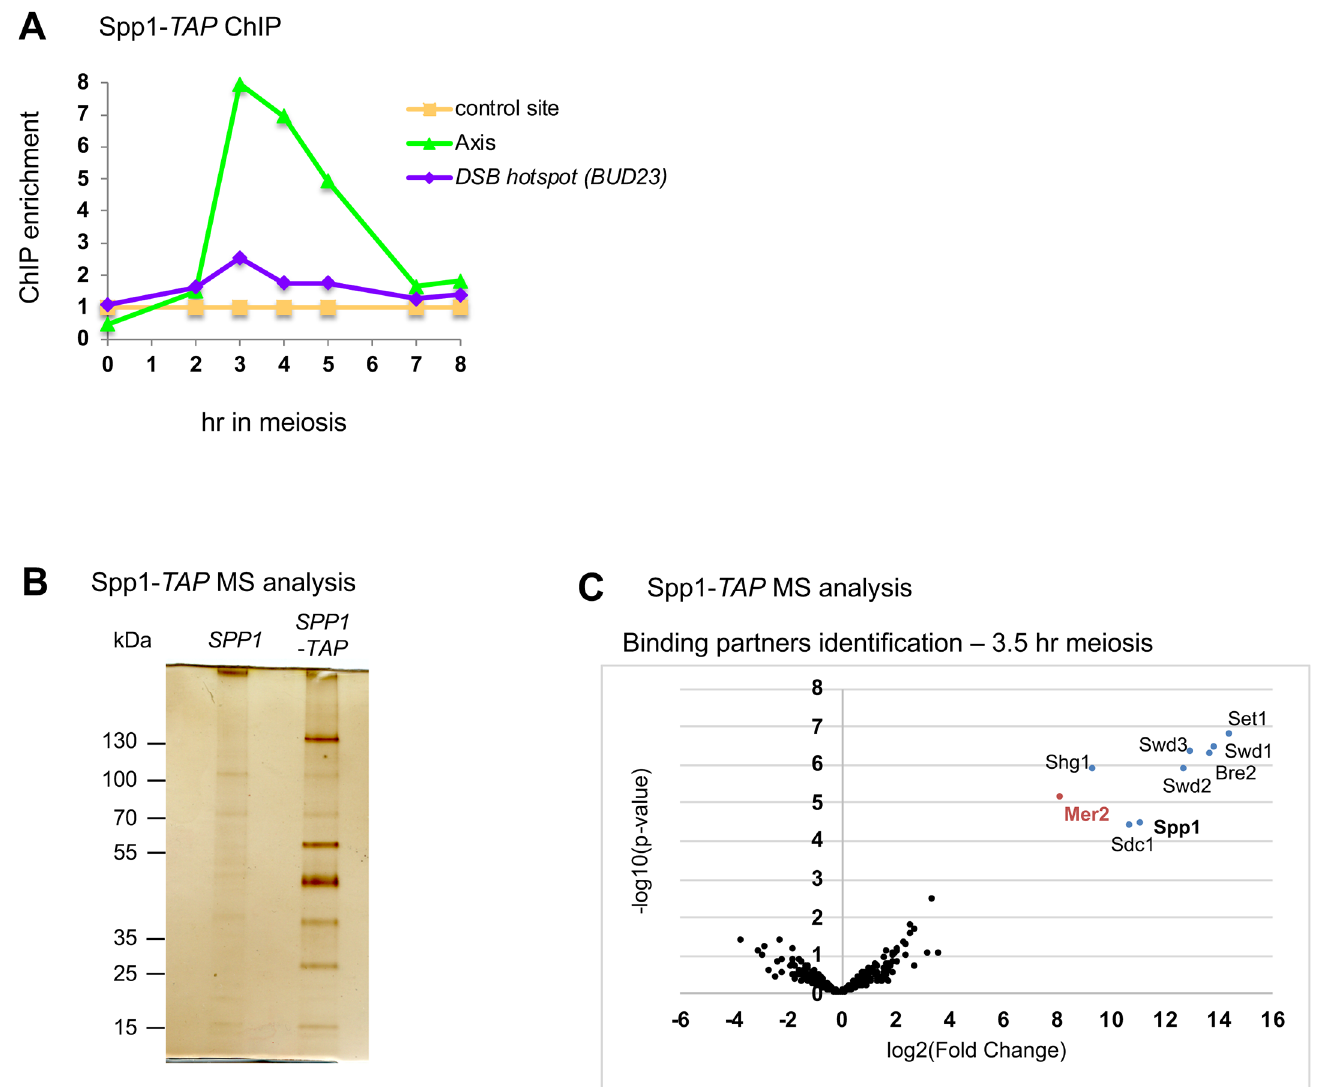
Fig 1. Spp1 interacts with the Set1 complex and the Mer2 DSB protein in meiotic cells. (A) ChIP-qPCR of Spp1-TAP during meiosis, showing its association with the chromosome axis at 3–4 hr, the expected time for DSB formation. Strain: VBD1266. Sites used for negative control ( NFT1 gene) and axis (chr 3, nt 232942 to 233010) are the same in all figures. (B) Silver-stained gel of TAP eluates performed at 3.5 hr in meiosis in untagged (ORD7339) or Spp1-TAP (VBD1266). (C) Mass spectrometry analysis of proteins pulled down by Spp1-TAP in meiosis (t = 3.5 hr). SPP1-TAP : VBD1266 –no tag: ORD7339. The volcano plot indicates in red (Mer2) and in blue (Set1 complex subunits) the proteins that significantly co-purify with Spp1 (log2(Fold change) > 3 and log10(p-value) < 4). The experiment was done in three biological replicates, and average Fold Change values over the untagged control are presented with their corresponding p-value (see Methods).